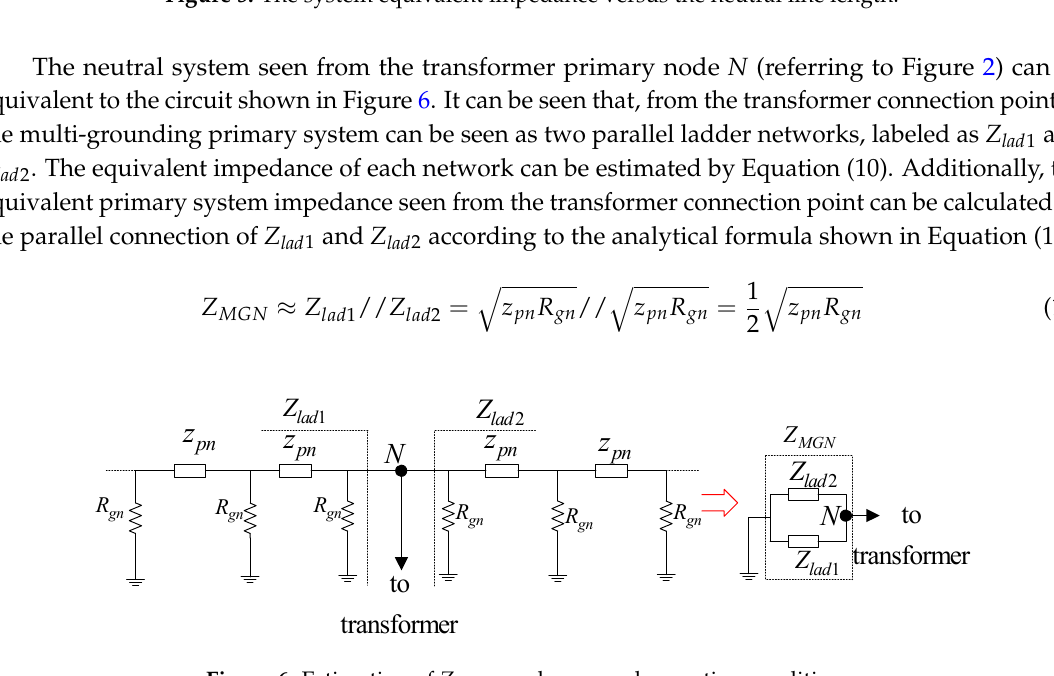
Figure 6. Estimation of Z MGN under normal operating conditions.